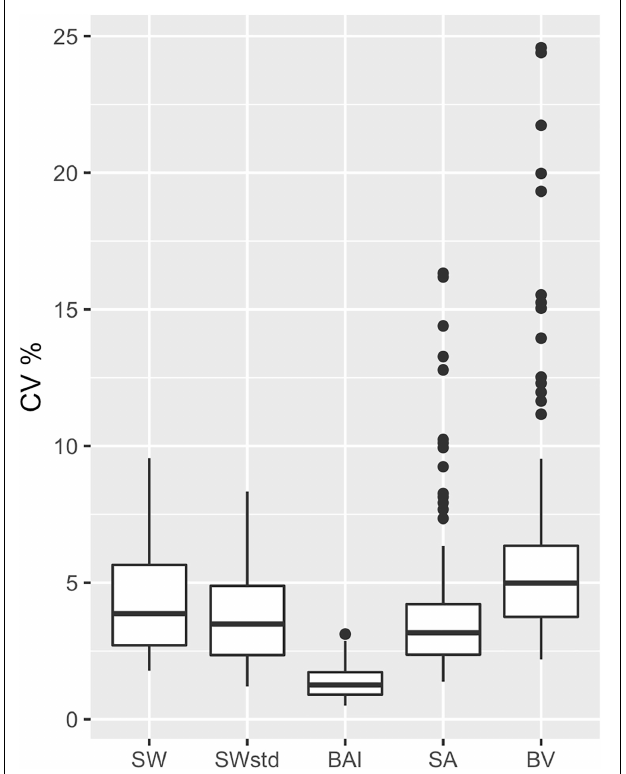
FIGURE 6 | Comparison of metric precision. The coefficient of variation (CV%) was calculated from the posterior predictive distribution for each body condition metric for each individual. SW, single width (1D); SW std , standardized single width (Eq. 11) (1D); BAI, body area index (2D) (Eq. 14); SA, surface area (2D) (Eq. 13); and BV, body volume (Eq. 16). The middle line in each box represents the median, or second quartile (50th percentile), the lower and upper hinge of the box represent the first and third quartile (the 25th and 75th percentile), respectively, and the lower and upper whisker represents the smallest and largest value that at extend at most 1.5 × IQR, where IQR is the interquartile range. Any data beyond these whiskers are considered outlying points and plotted